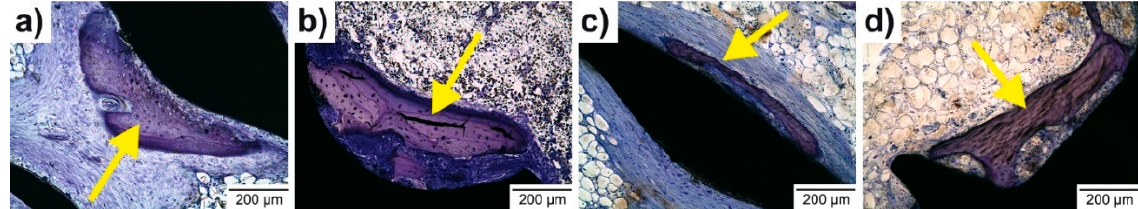
Figure 8. Peri ‐ implant bone formation (arrows), variable thickness of newly formed bone on the surface of the implanted screws (marked by the yellow arrows) ( a ) 120 days after experimental screw implantation, ( b ) 240 days after experimental screw implantation, ( c ) 360 days after experimental screw implantation. ( d ) Control 360 days after Ti ‐ based screw implantation.